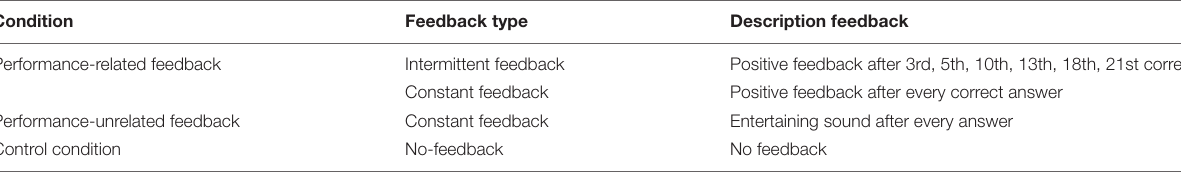
TABLE 2 | Descriptive statistics Standard deviations (SD) in